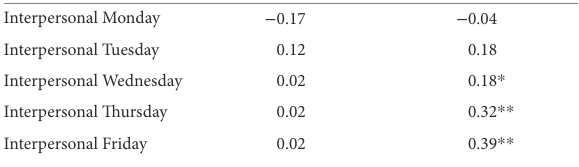
TABLE 8 Results of Spearman’s correlations of interpersonal conflicts and conflicts at home throughout the week. Afternoon conflict Evening